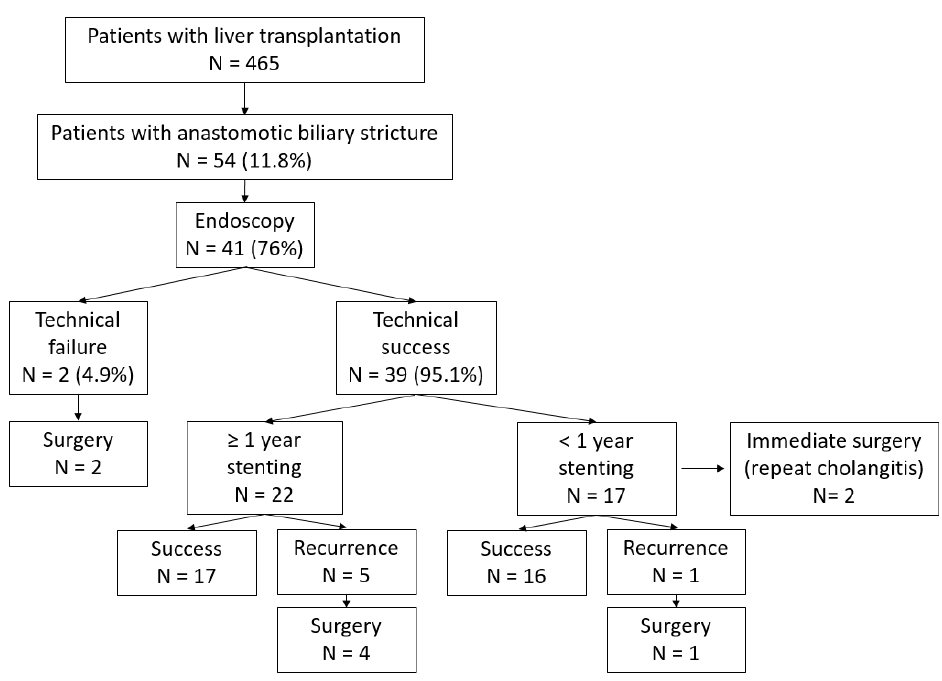
Figure 1. Flow chart.